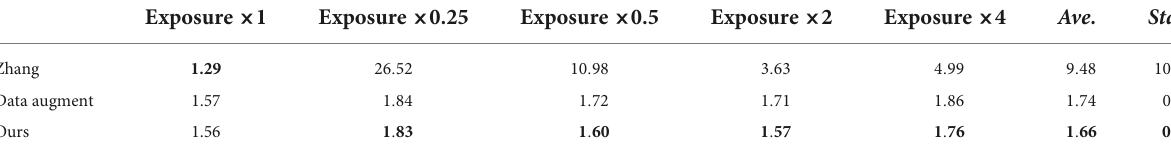
TABLE 7 Comparison of spectral angle mapping (SAM) errors of different optimization methods under different tested exposure levels. Exposure × 1 Exposure × 0.25 Exposure × 0.5 Exposure × 2 Exposure × 4 Ave. Std.